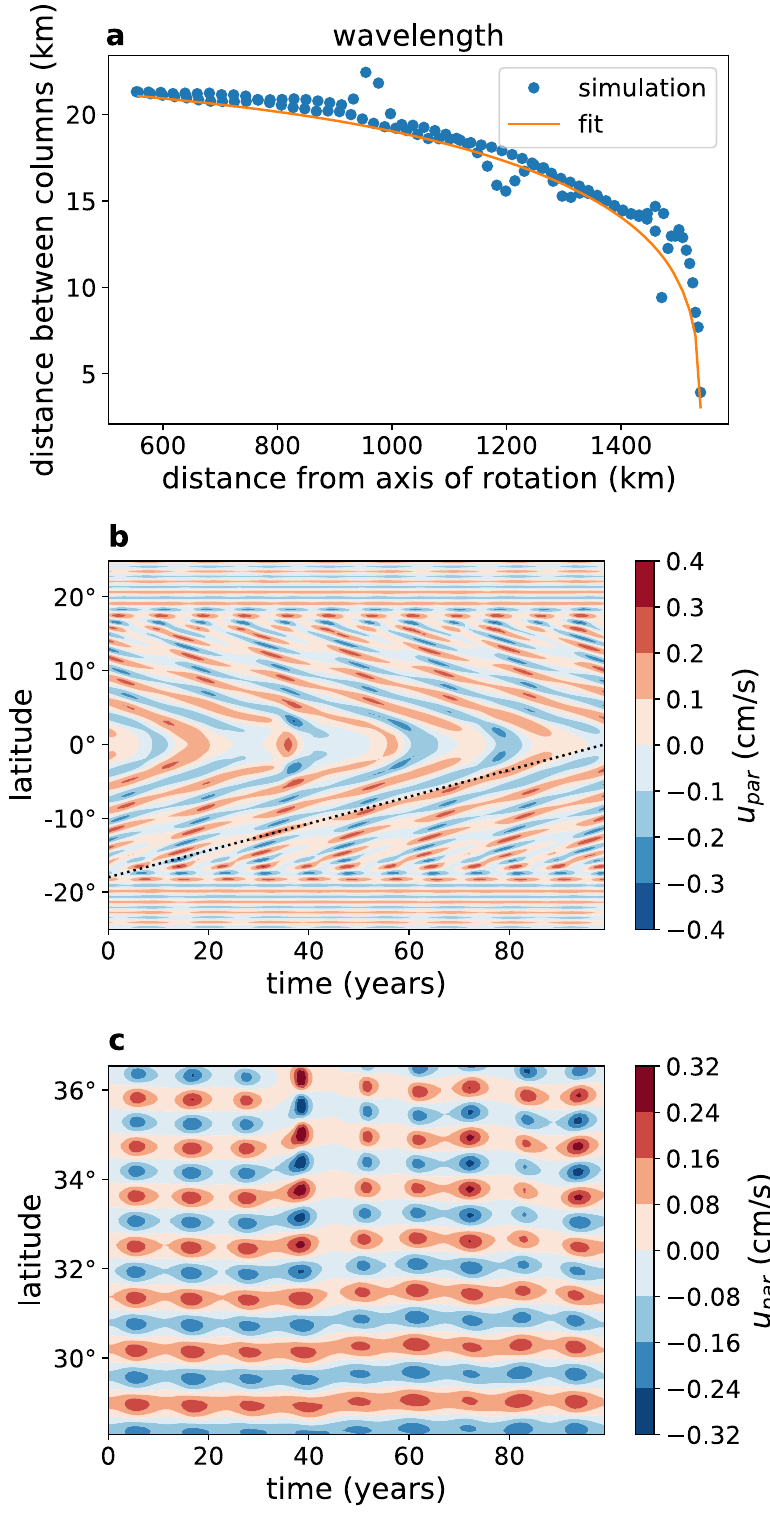
Fig. 3 The dynamics and structure of the Taylor columns. a The distance (km) between the Taylor columns in the 2d simulation as a function of the distance from the axis of rotation (km), based on a snapshot of the velocity parallel to the axis of rotation, u par at a depth of 13 km under the ice-ocean interface. Full circles represent the numerically estimated distances while the solid line represents the functional fi t, see text. b The velocity parallel to the axis of rotation (cm s − 1 ) as a function of latitude and time (Earth years) at a depth of 19 km under the ice. The fi gure shows the equatorward propagation of the Taylor columns, where the slope of the shown dashed line corresponds to a propagation velocity of 0.18° per year. c Same as b , showing a region inside the tangent cylinder (at depth of 49 km under the ice), where the Taylor columns are